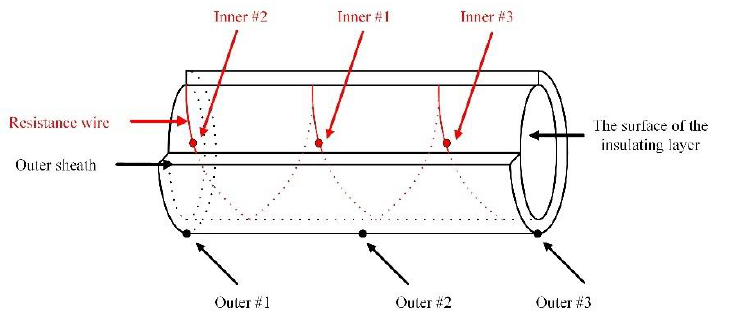
Figure 14. The diagram of thermocouple layout. (The solid dots represent the six thermocouples).